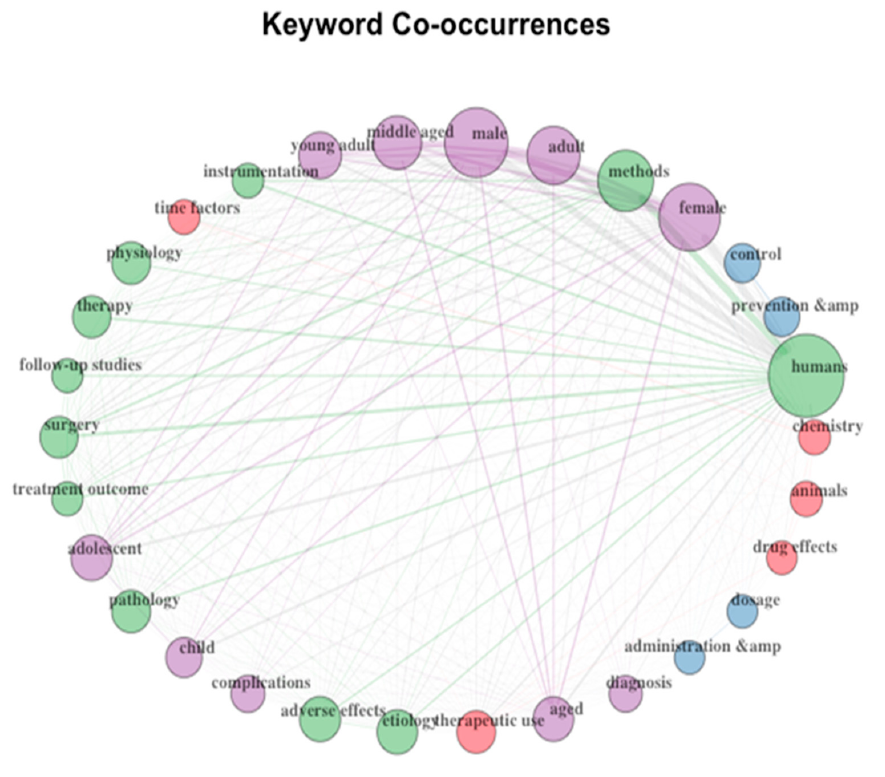
Figure 3. Keyword co-occurrences.